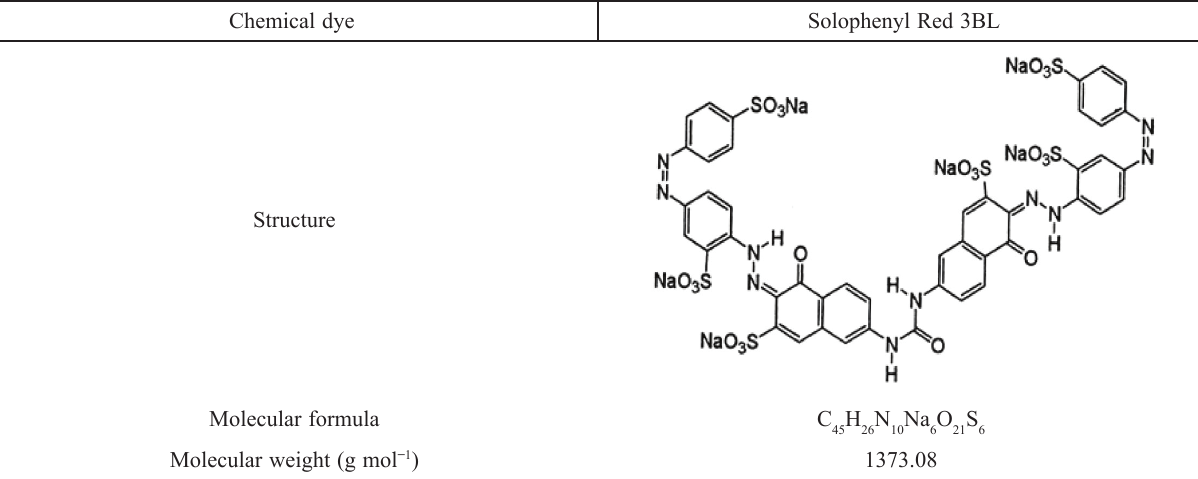
Table 1 – Molecular structure, molecular weight and chemical formula of SR 3BL Chemical